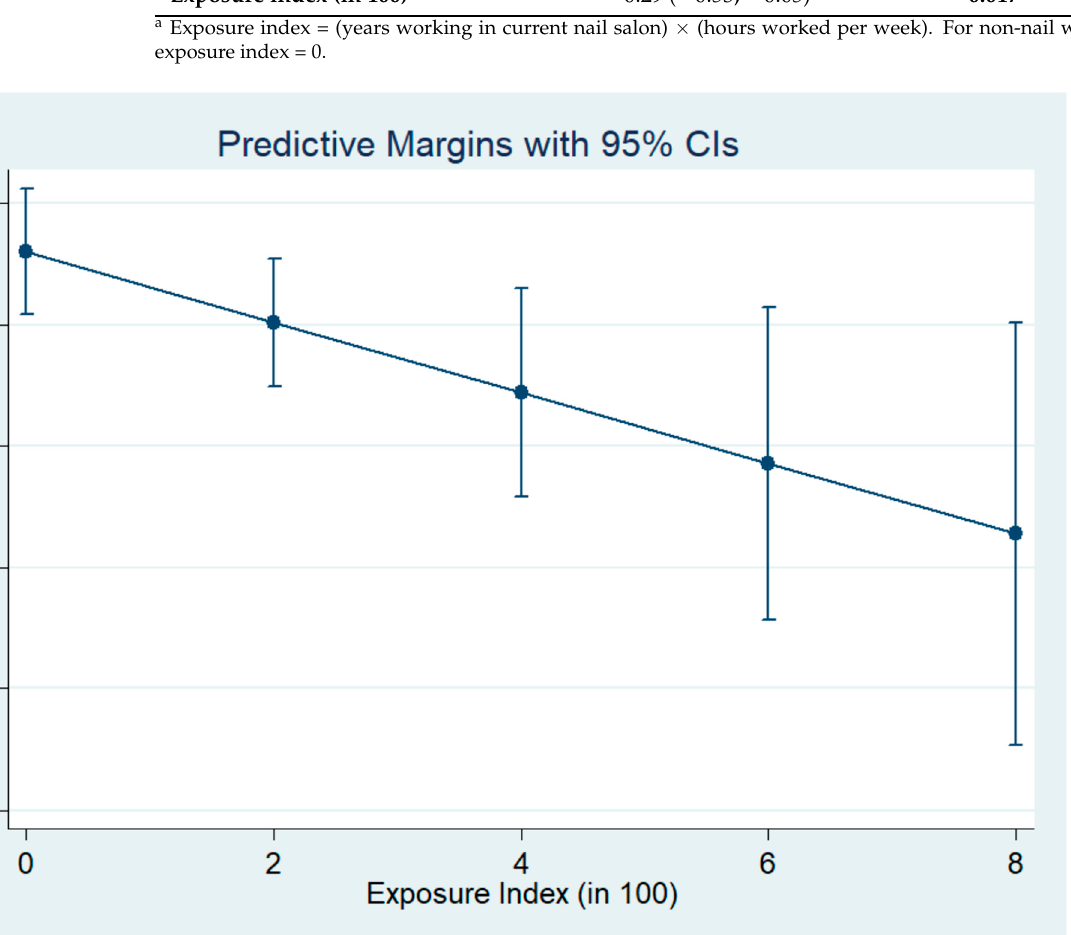
Figure 1. Predictive margins for the Montreal measure of cognitive assessment (MoCA) and 95% CIs at different values of exposure index averaged across other factors, based on the fitted multiple linear regression ( n = 269). Exposure index = (years working in current nail salon) × (hours worked per week). For non-nail workers, exposure index = 0.